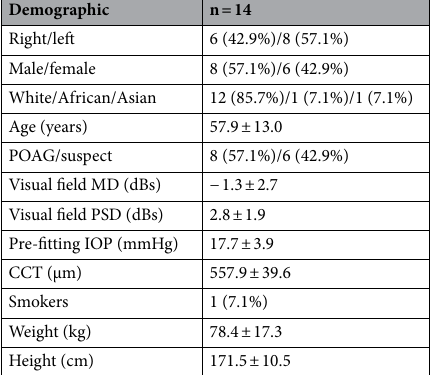
Table 1. Demographics and characteristics of enrolled patients who reported relevant events in their diaries (POAG: Primary open-angle glaucoma; MD: Mean defect; PSD: Pattern standard deviation; IOP: Intraocular pressure; CCT: Central corneal